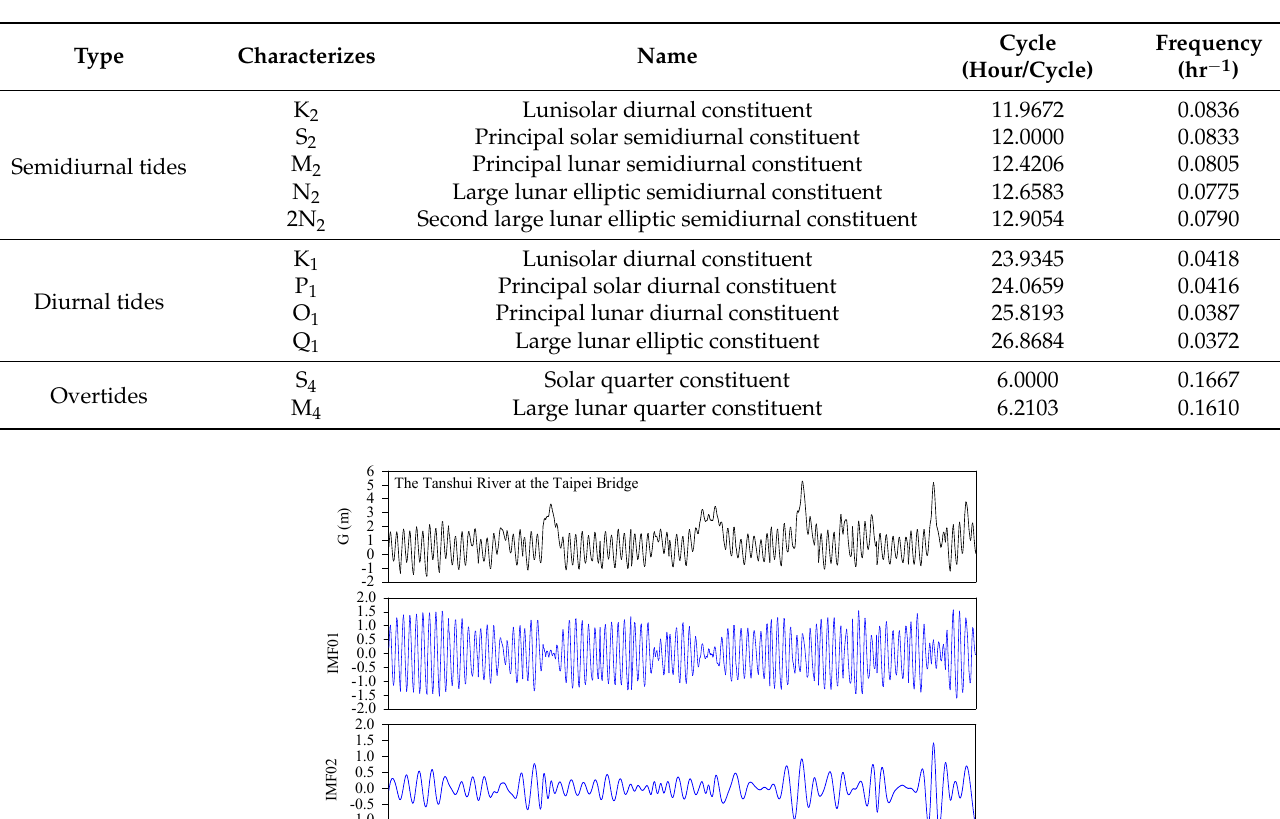
Table 3. The classical tidal type.